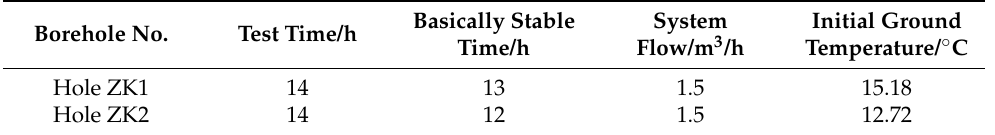
Table 2. Test result of initial ground temperature. Borehole